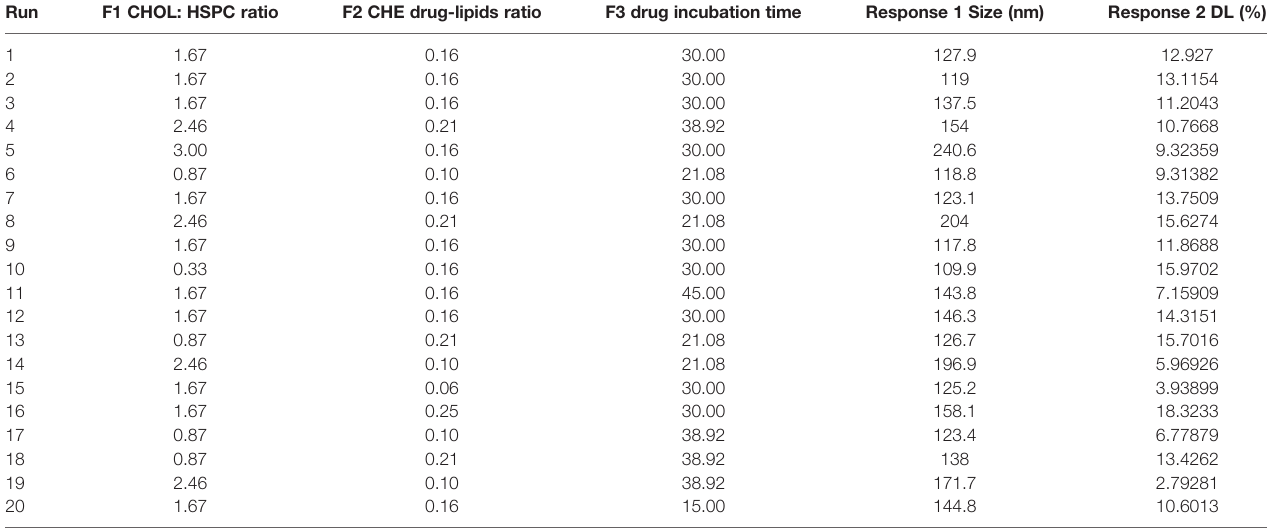
TABLE 4 | Design and results.